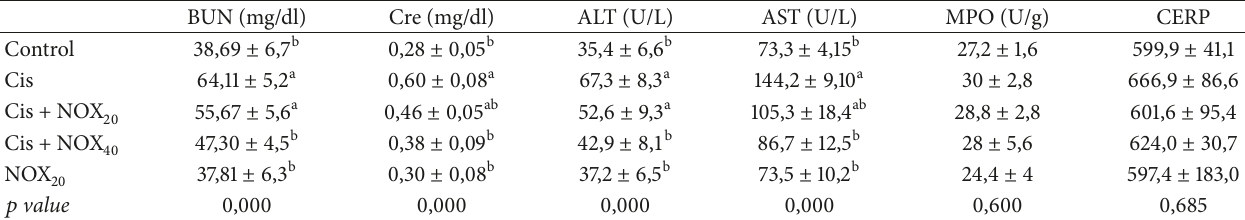
Table 4: Effect of naringenin oxime (NOX) on serum liver enzymes, renal function markers, myeloperoxidase (MPO), and ceruloplasmin (CERP) of cisplatin induced